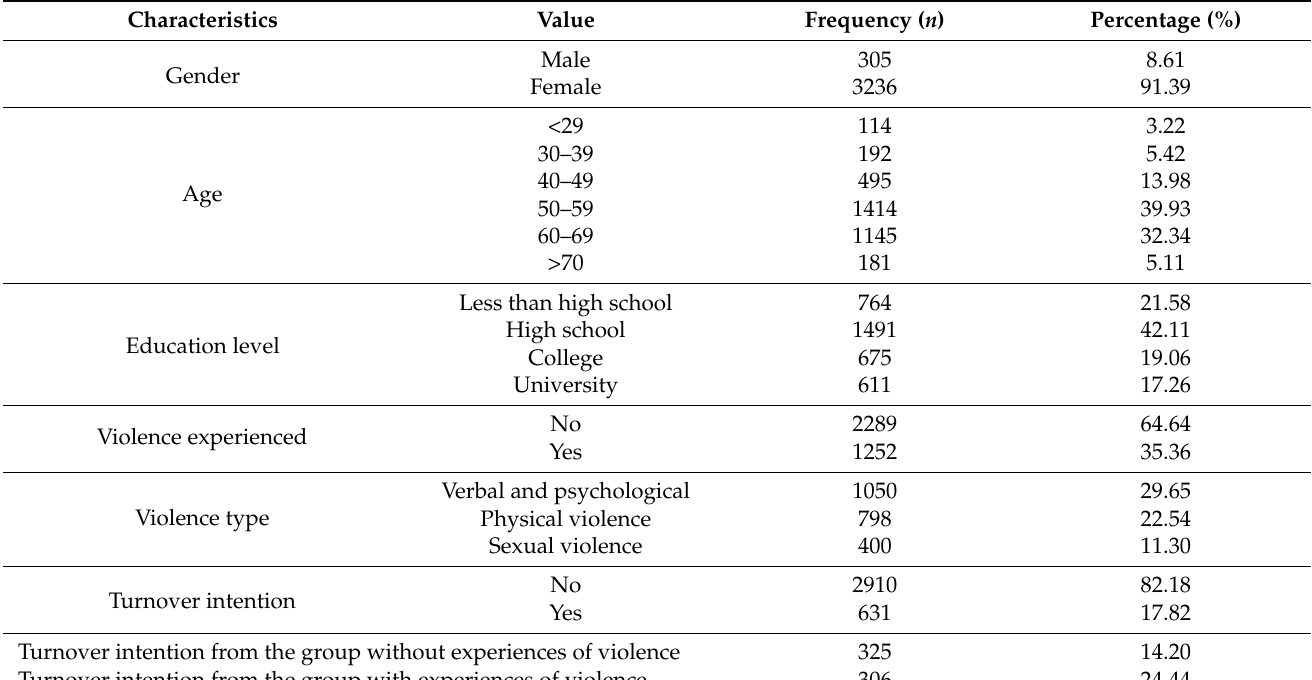
Table 2. Participant characteristics ( n =